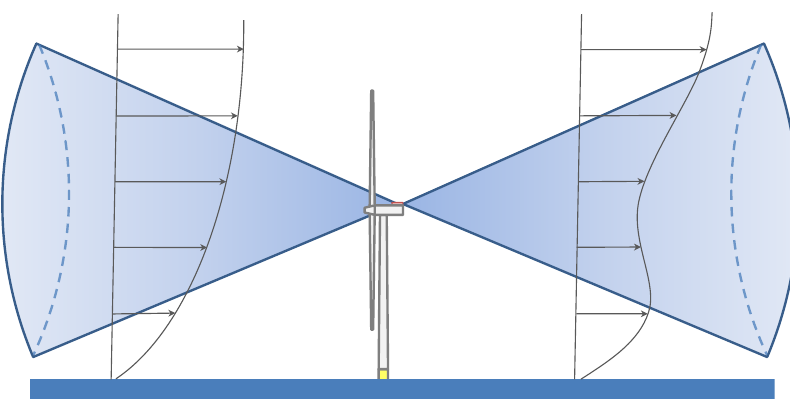
Figure 4. Sketch of the lidar setup with one lidar dedicated to the measurement of the incoming flow conditions and another one dedicated to the characterization of the